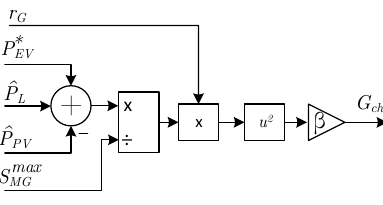
Figure 3. Schematic diagram of the G ch